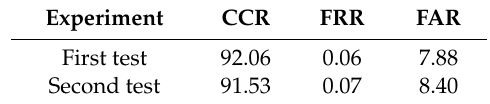
women for the first and second series of